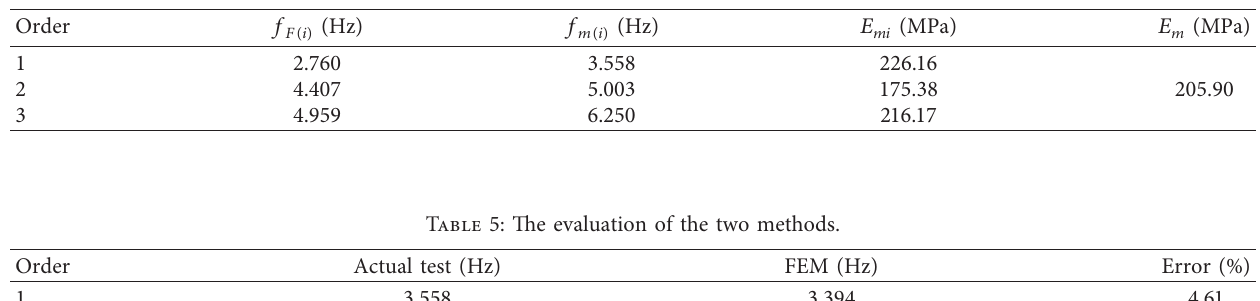
Figure 9: First three orders of modes of vibration. (a) First-order transverse bending. (b) Second-order left and right torsion. (c) Third-order vertical bending. Table 4: The calculation results.